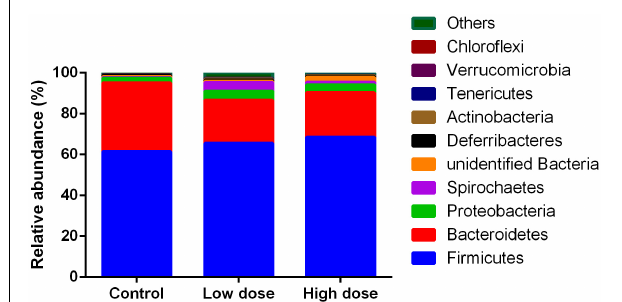
FIGURE 1 | Relative abundance of operational taxonomic units among control group (0 mg/kg 6-MBOA), low 6-MBOA dose group (1 mg/kg 6-MBOA) and high 6-MBOA dose group (2 mg/kg 6-MBOA) at the phylum level in the cecal microbiota of adult male Brandt’s vole. Others mean the phyla with relative abundance less than